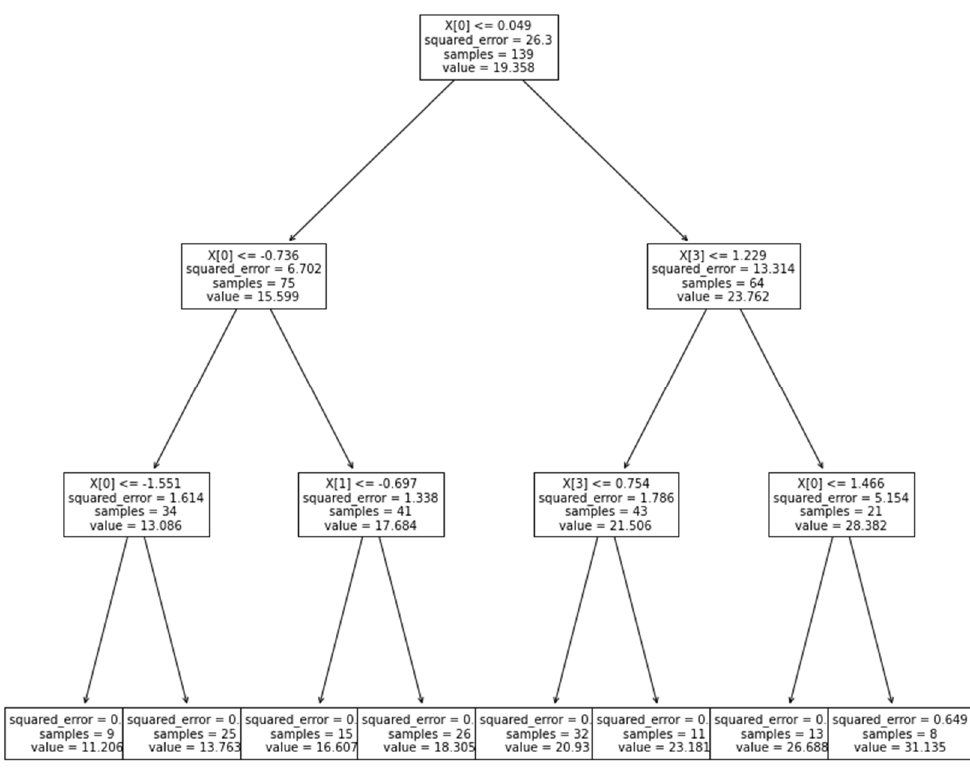
Figure 7. Decision tree for c (MPa).